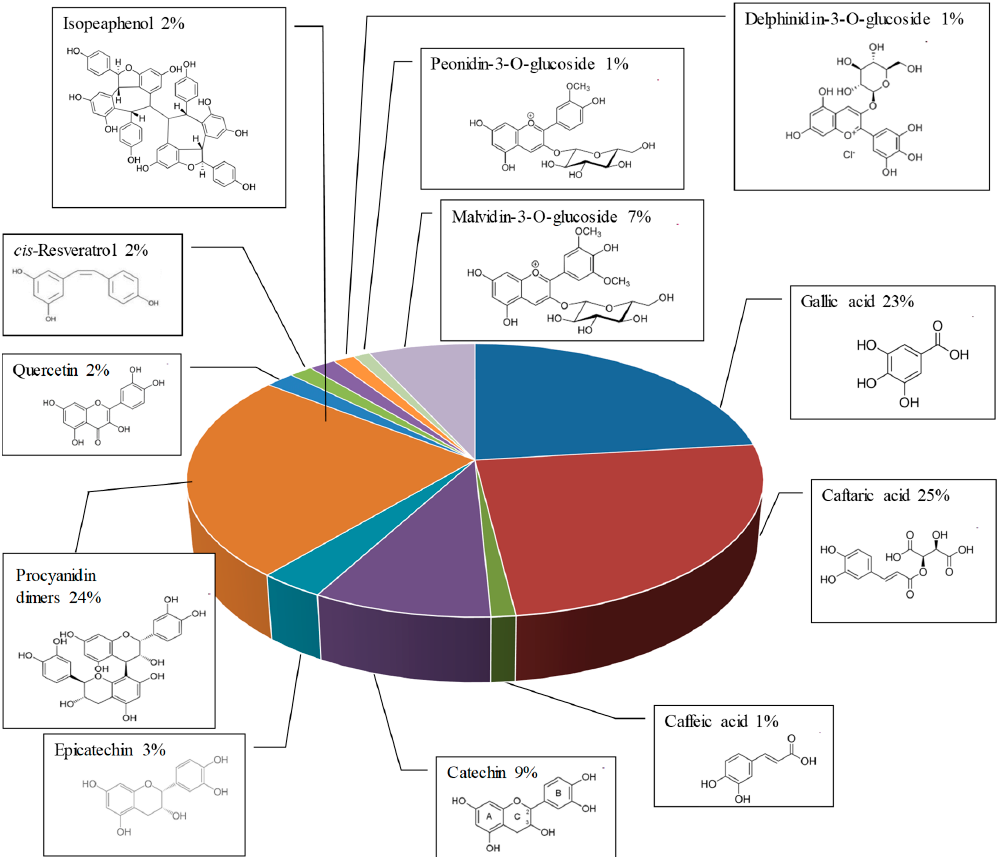
Figure 3. Quantitative analysis of red wine extract content and chemical structures of the main polyphenolic compounds.